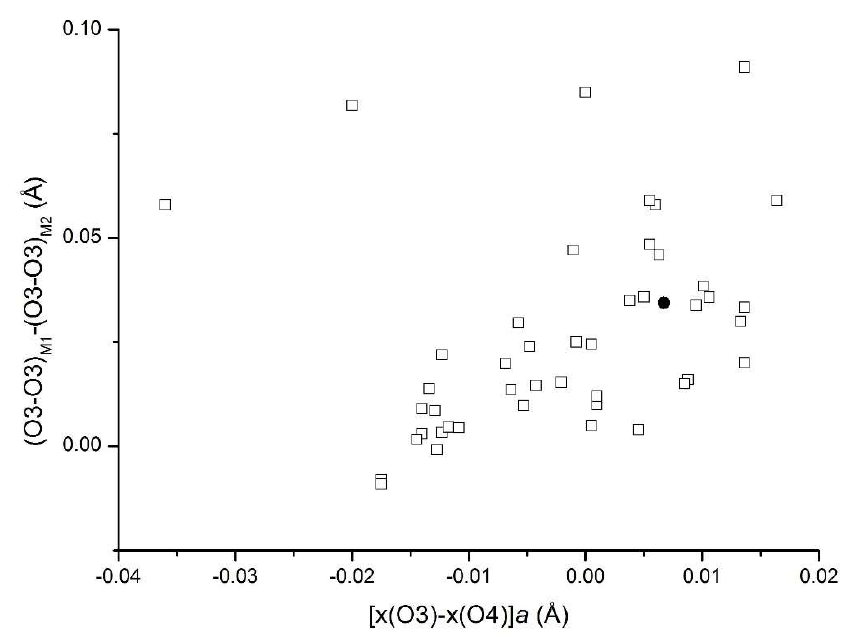
Figure 6. Plot of the O3 hexagon distortion vs. the O4 atom offset from the “octahedral hexagon center”. Symbols: open squares—from Mesto et al. [28]; filled circle—this study.